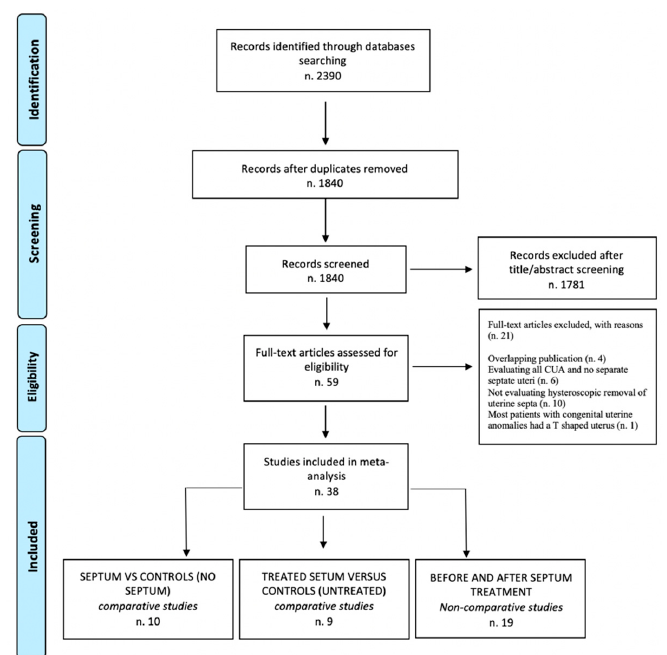
Figure 1. Flowchart summarizing literature identification and selection [65].